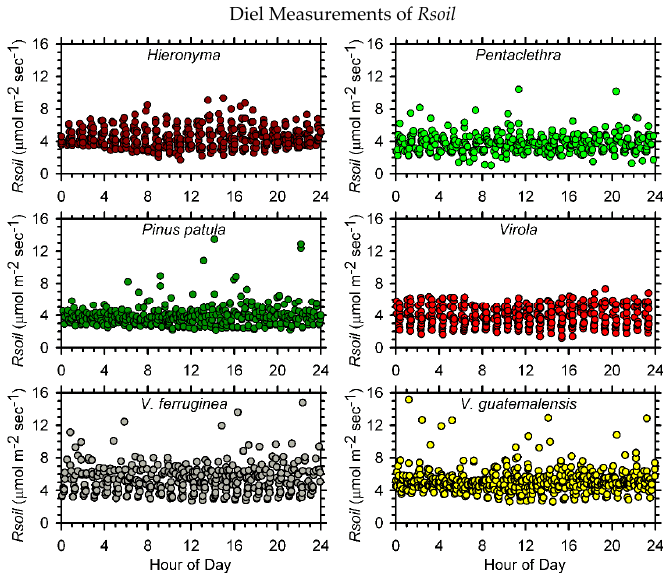
Figure 1. Soil respiration was highly variable at all hours of the day and night, within all plantation types. This figure includes all data collected during diel measurement periods ( N = 2650).